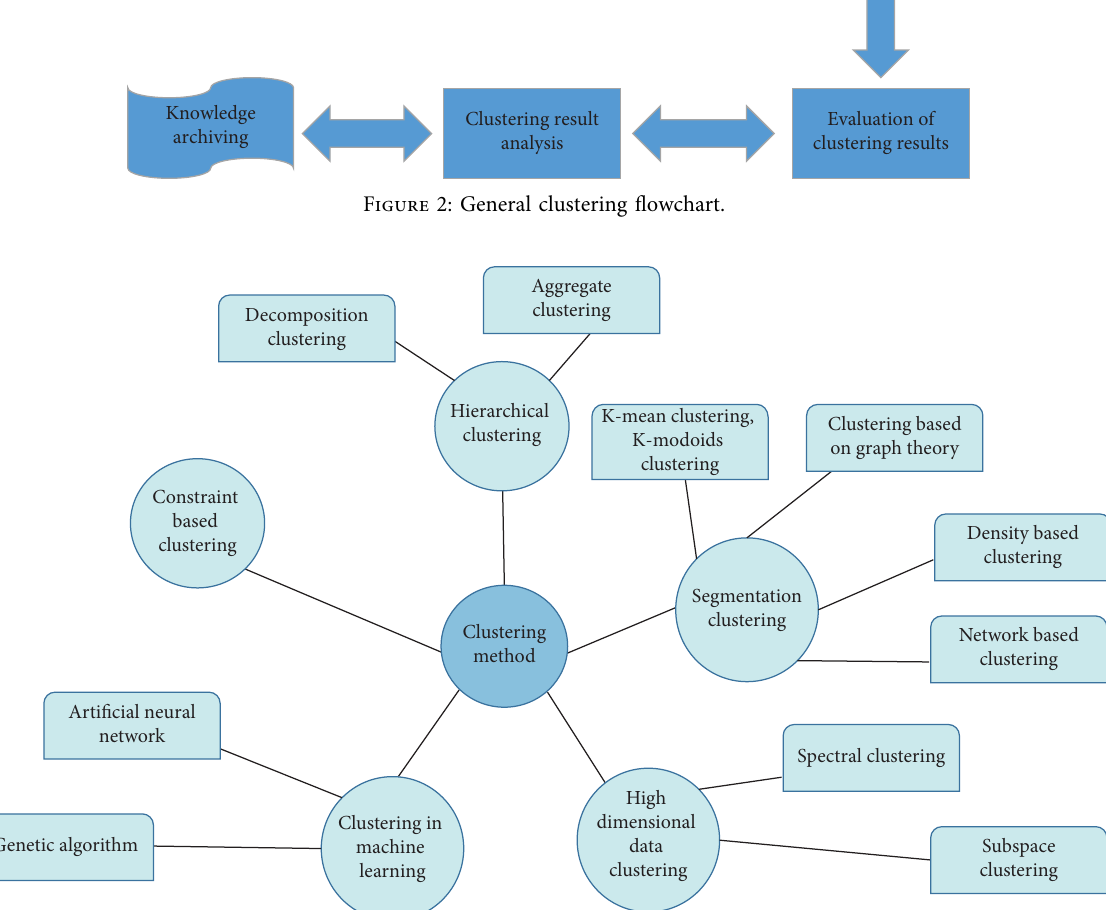
Figure 3: Clustering algorithm in data